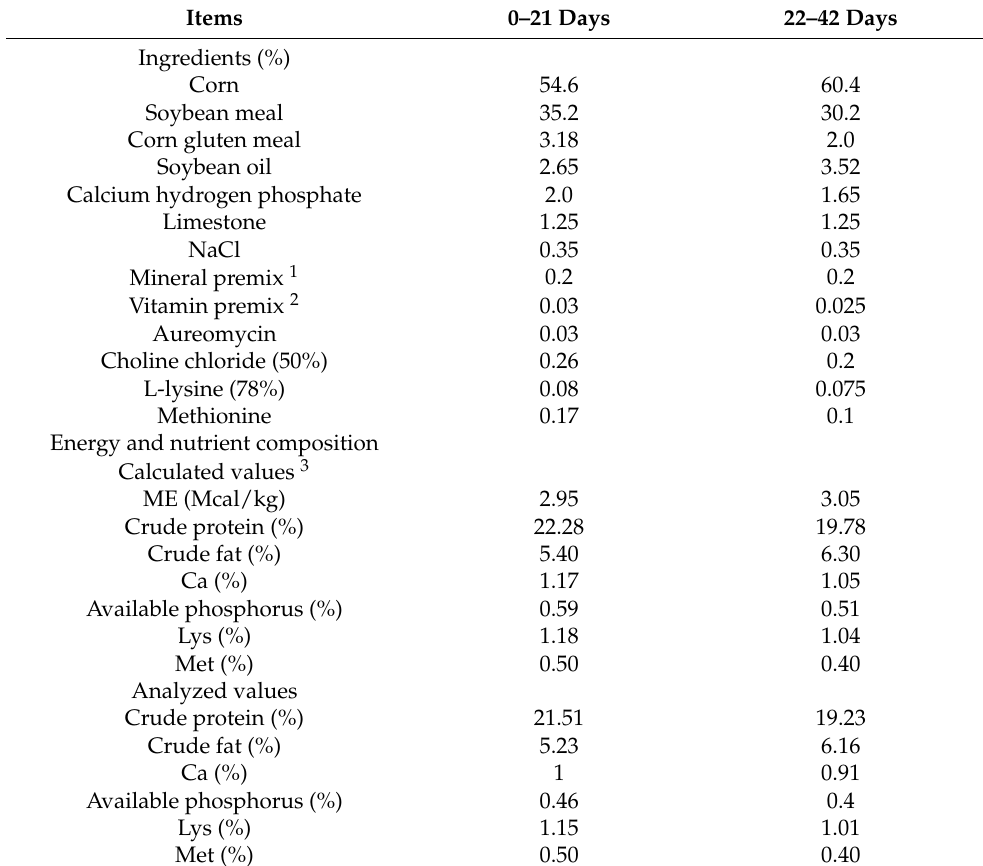
Table 1. Diet composition and nutrient levels during the experiment (basal diets in dry